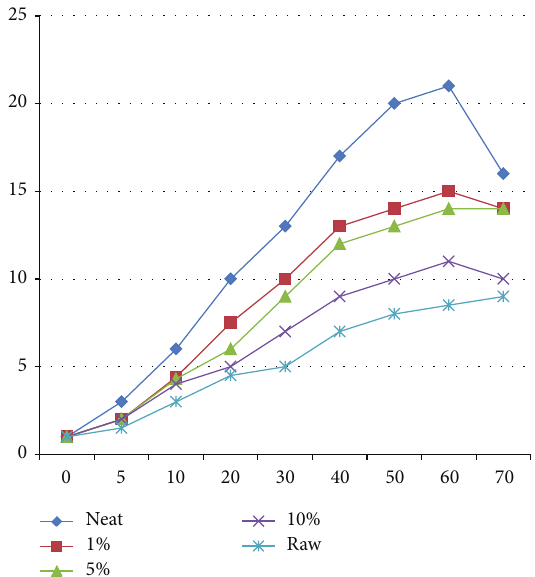
Figure 4: Mechanical strength of the graphene reinforced compos- ites materials.